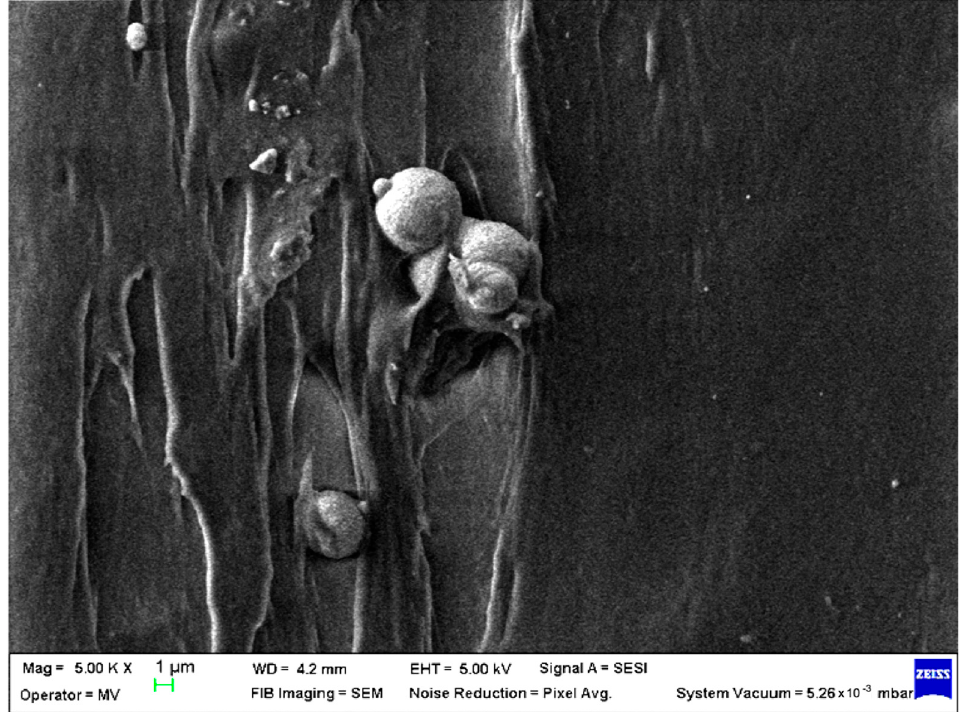
Figure 10. SEM micrographs of PET–PP–Fe composite (M10) sample at T 0 (1 μ m scale).